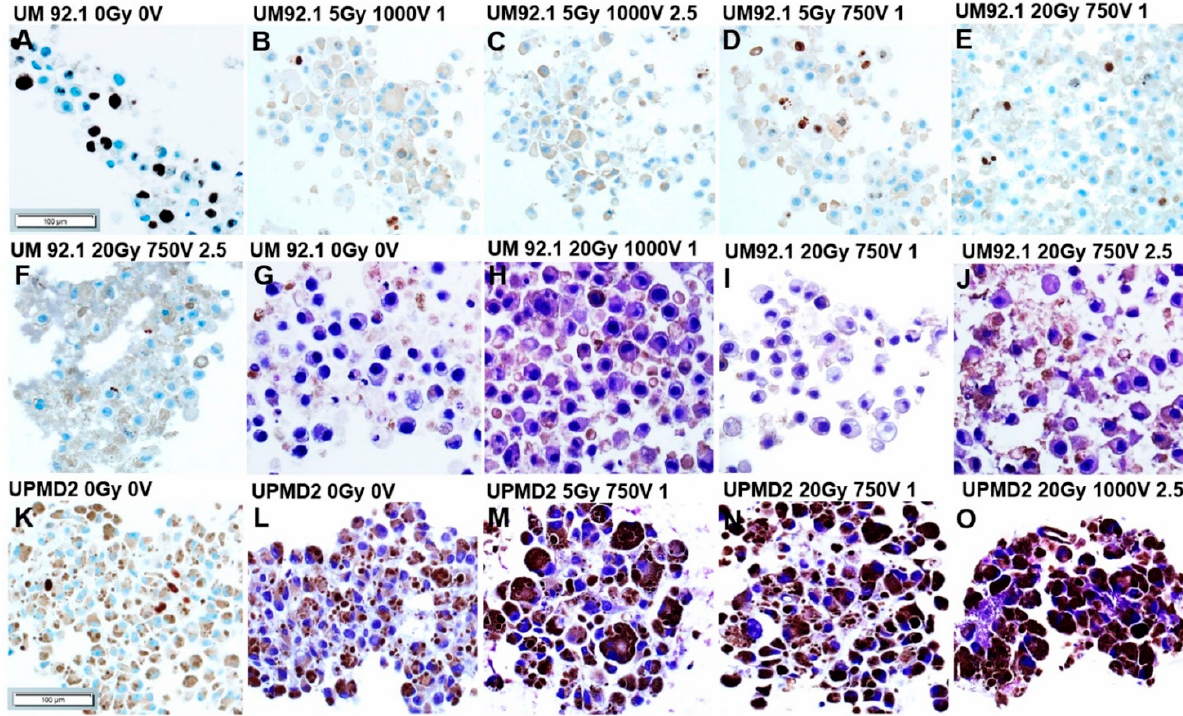
Figure 3. Immunohistochemistry of 3D tumor spheroids treated with combination therapy. Tumor spheroids were irradiated (dose 5 or 20 Gy) and treated with ECT (electroporated 1000 V or 750 V in the presence of 1µg/mL or 2.5 µg/mL bleomycin) or were left untreated (0 Gy 0 V). ( A – F , K ) UM92.1 or UPMD2 spheroids ( n = 3–6 each condition) were stained for proliferation marker Ki67; ( G – J , L – O ) and/or stained with hematoxylin. Representative images are shown (200 × magnification; scale bar of figure 3 represents 100 µm).